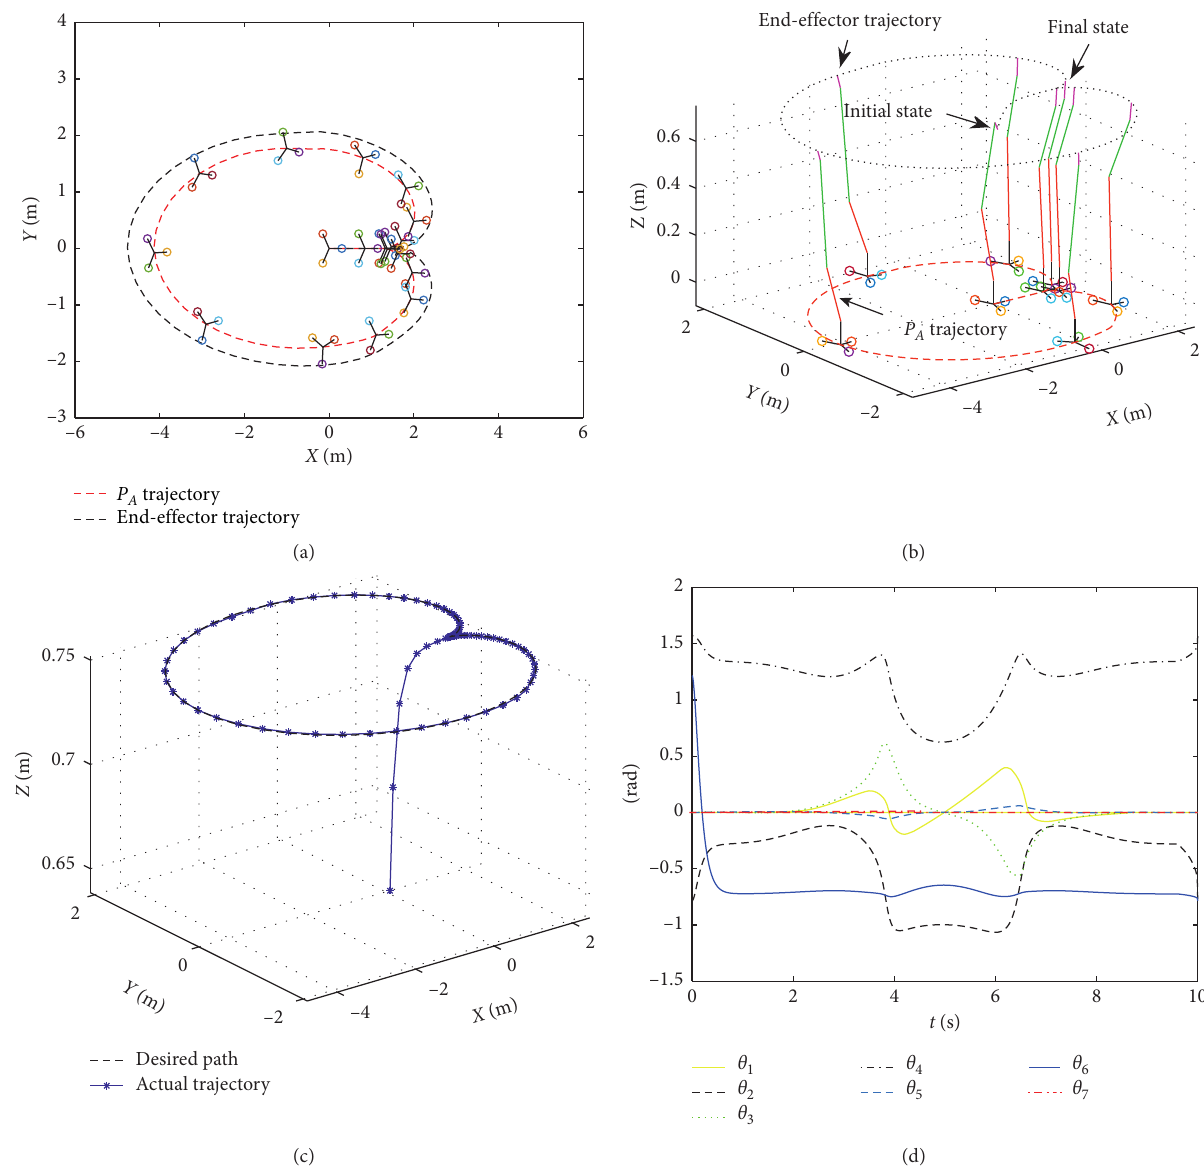
Figure 6: Simulation results of EVPNN model (23) without noise when the end effector of the PA10 mobile robot tracks the cardioid path. (a) Top view of trajectories of the end effector and platform with three wheels. (b) Horizontal view for the entire mobile manipulator. (c) Desired path and actual trajectory. (d) Profiles of joint angles θ